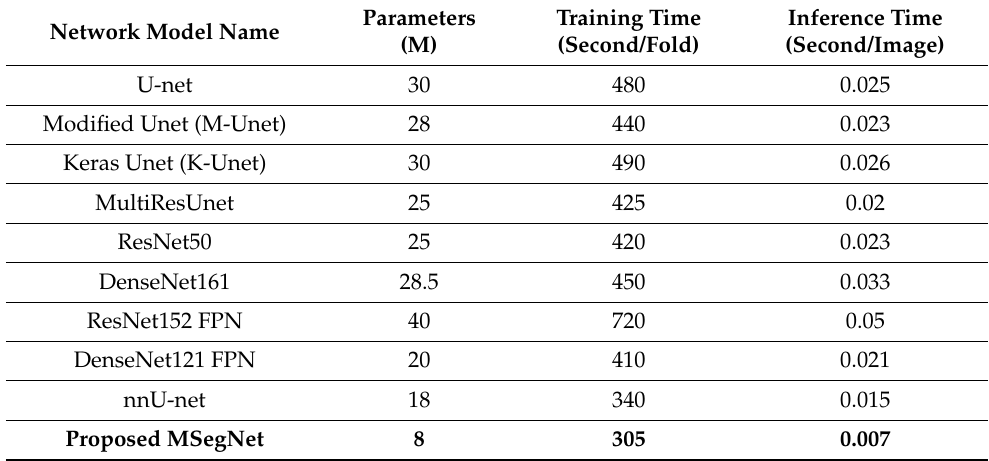
Table 7. Computational complexity comparison of the proposed model with Unet based